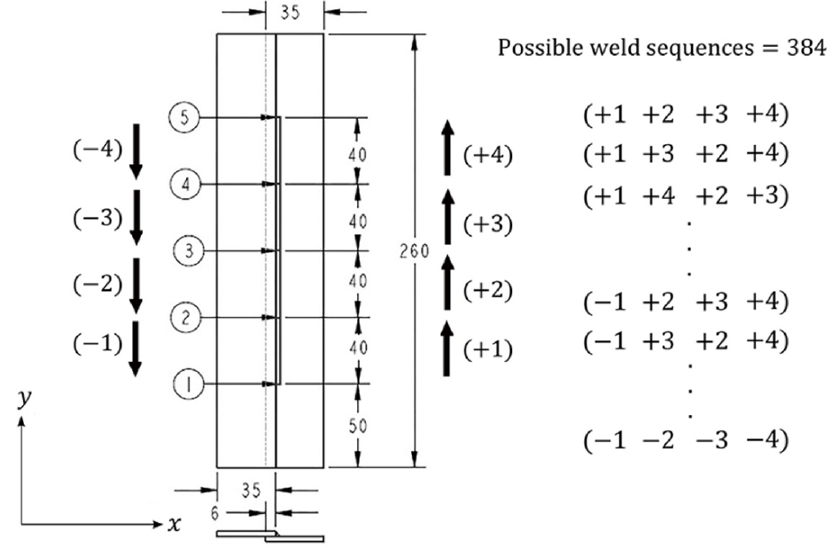
Figure 11. Dimensional model of weld sequence optimization study.